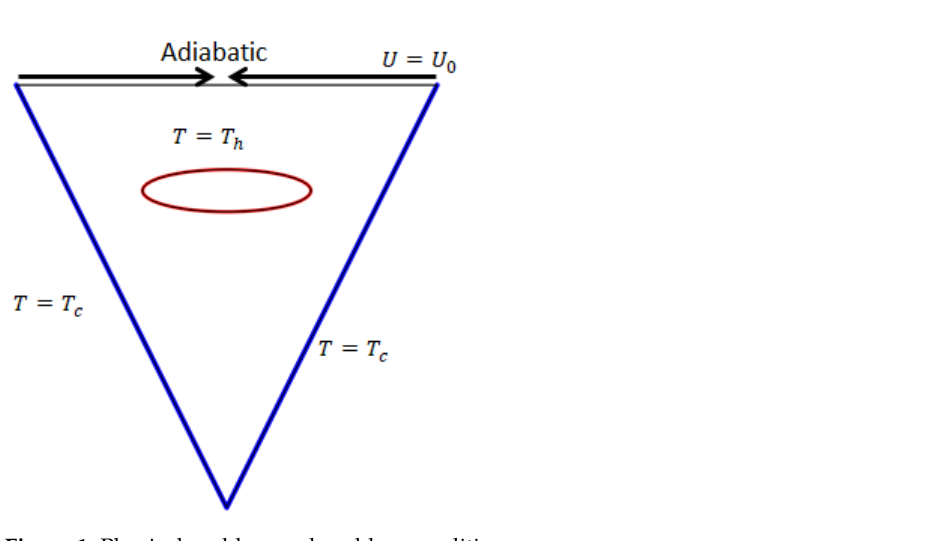
Figure 1. Physical problem and problem conditions.